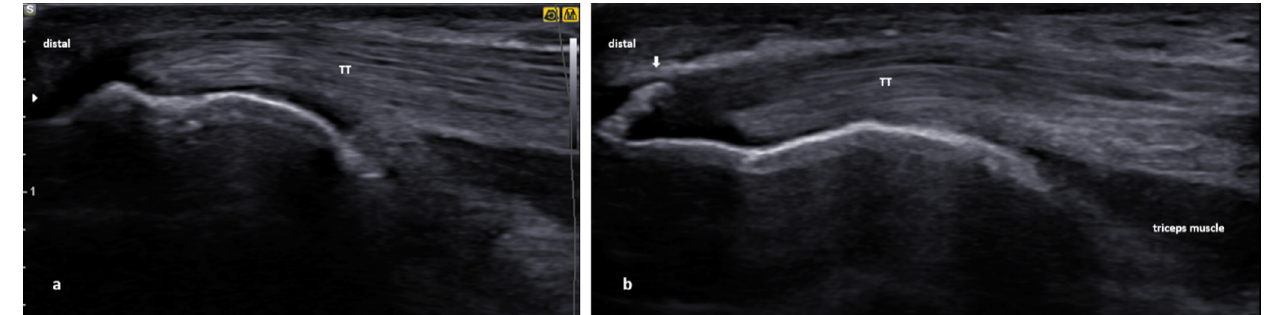
Figure 12. Ultrasound images of the distal triceps tendon (TT): ( a ) normal longitudinal image of the TT; ( b ) US image that demonstrates a prominent spur (white arrow) at the olecranon’s TT insertion site.